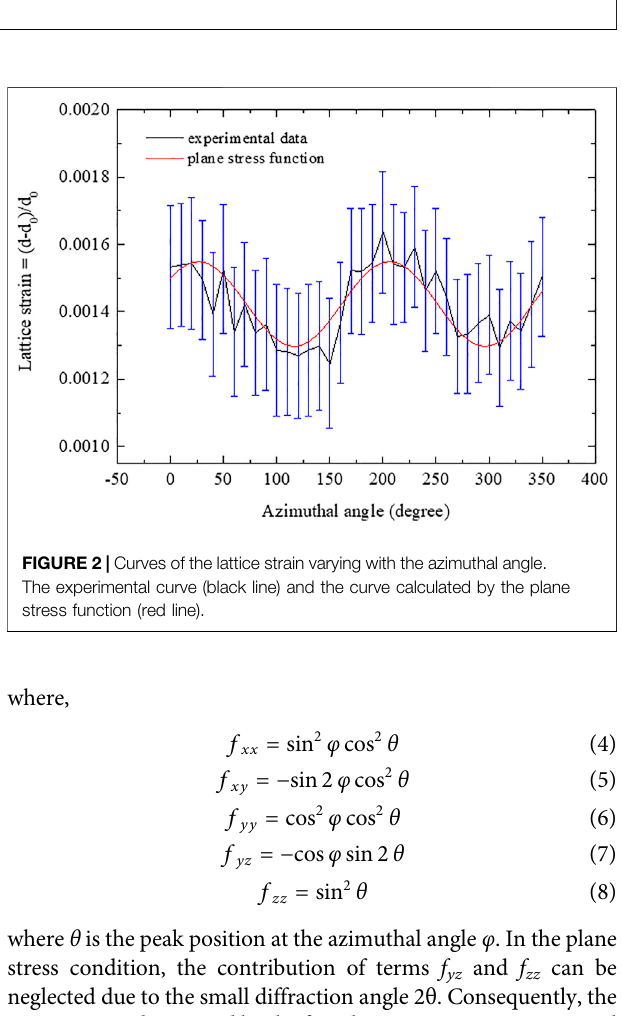
FIGURE 1 | Picture of the stress frame (unit: mm). L (longitudinal), N (through-thickness), and T (transverse) stand for the three orthogonal directions in the stress frame.